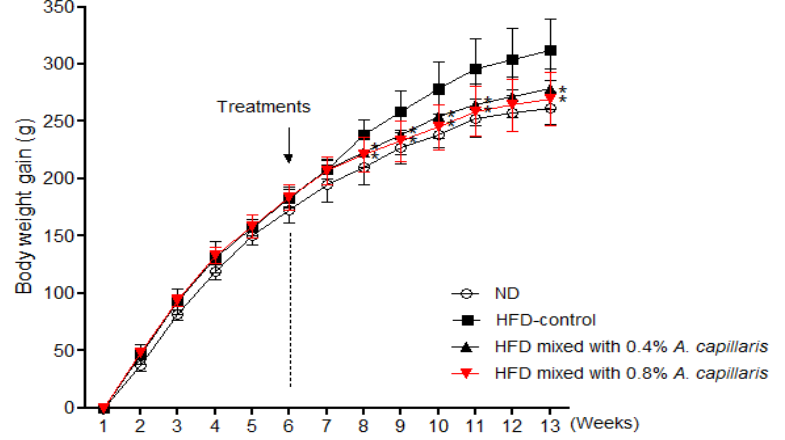
Figure 2. Effects of A. capillaris extracts on body weight gain in HFD-induced obese rats. The body weight of the animals was recorded weekly during the experimental period. The body weight gain was calculated by the equation: final body weight − initial body